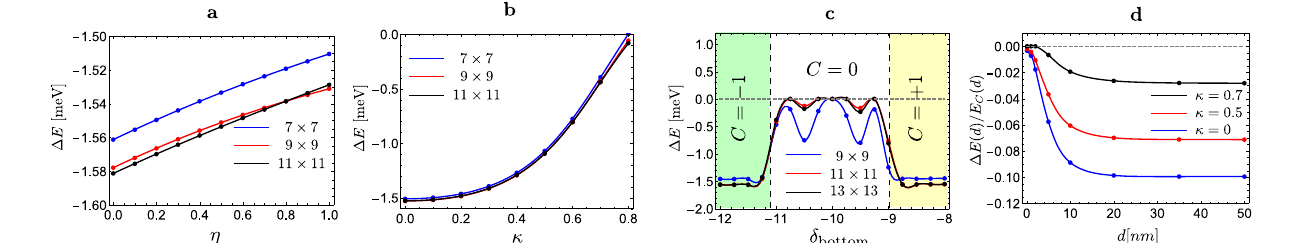
Fig. 1 | Binding energy of the polaron-bound state for fl at quasiparticle dis- persion. The plot of the binding energy for fl at quasiparticle dispersion ( a ) as we extrapolatebetweentheLLLintheuniform fi eldandchiralTBGwavefunctions, b as